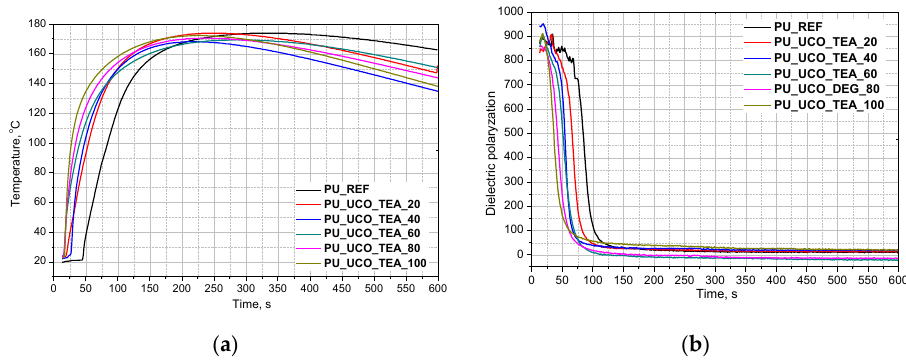
Figure 2. Foams core temperature profiles ( a ) and dielectric polarization changes in time ( b ) during foaming process of PUR system based on